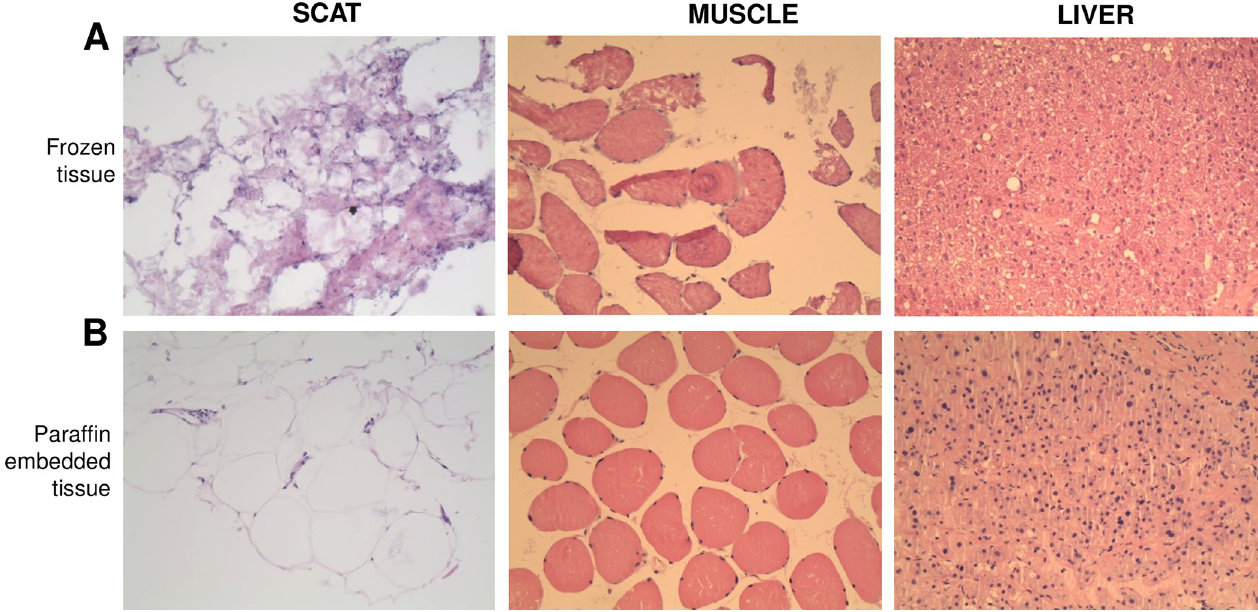
Fig 6. Histological integrity according to the time of sample storage in the biobank. Sections of SCAT, liver and muscle stored since 2016 were performed and stained with hematoxylin–eosine in 2020. Images were shown according to the material preparation protocol: (A) direct evaluation on frozen tissue sections (B) evaluation after the tissue was thawed, fixed and embedded in paraffin. Magnification is x200. SCAT, sub–cutaneous adipose